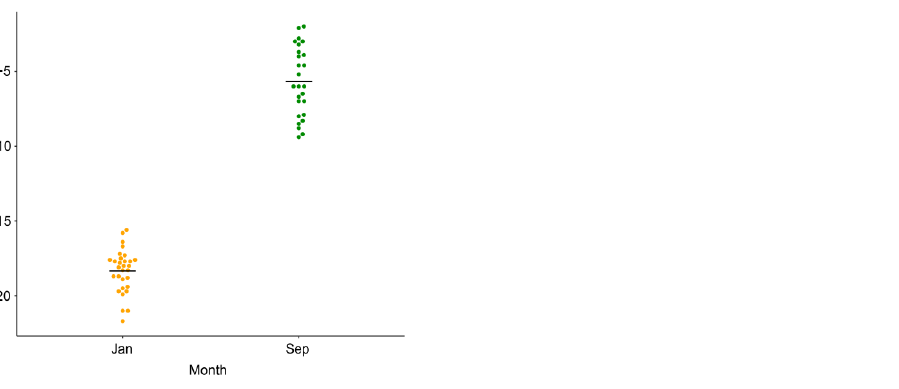
Figure 5. The supercooling points of larvae collected in January and September. Horizontal lines represent the means. Forests 2021 , 12 , x FOR PEER REVIEW